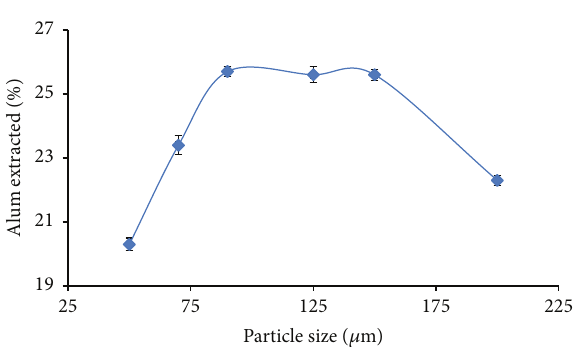
Figure 7: Effect of leaching time on the extraction of aluminum sulphate (acid concentration: 4M; particle size: 100 𝜇 m; leaching temperature: 100 ∘ C; error bar = ± SD; and 𝑛 = 3